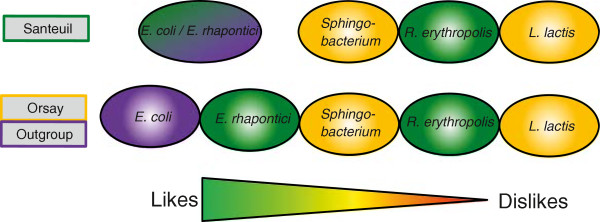
Preference of the strains from the different origins for the different bacteria. Strains are shown by rectangles (left), and bacteria by ellipses (right). Bacteria from Orsay are shown in orange, bacteroa frp, Santeuil strains in green, and standard laboratory food OP50 in purple.